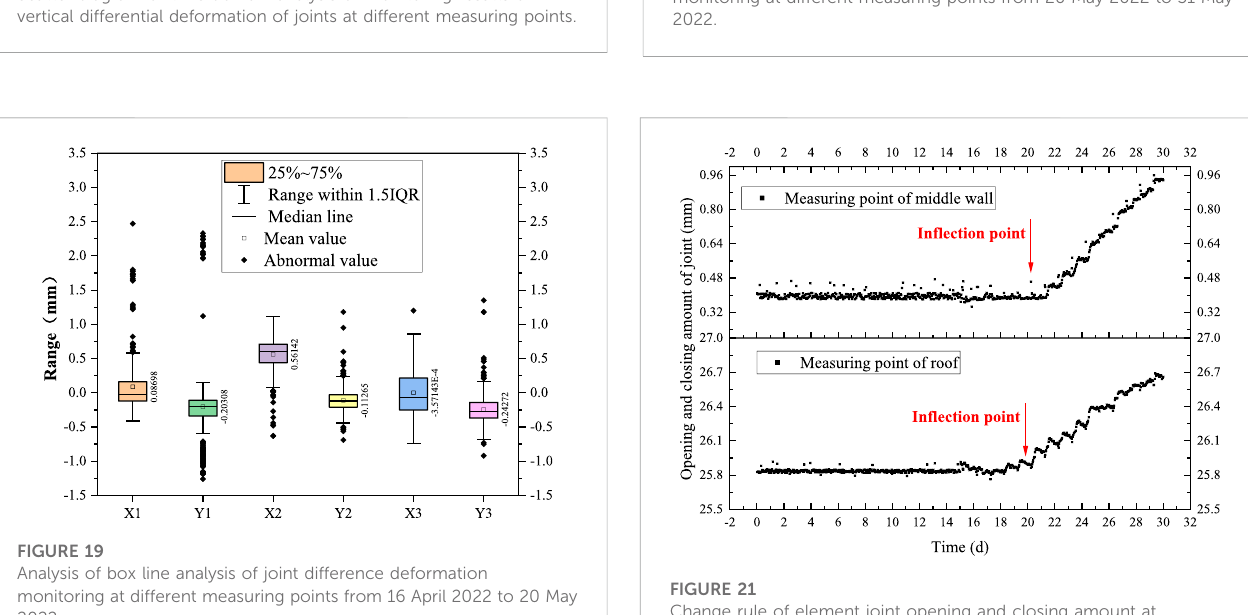
FIGURE 21 Change rule of element joint opening and closing amount at different measuring